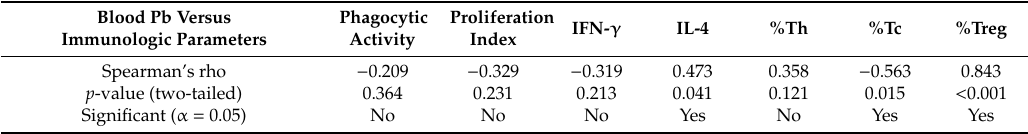
Table 3. The Spearman’s rank correlation analysis of blood Pb concentrations and seven immunologic